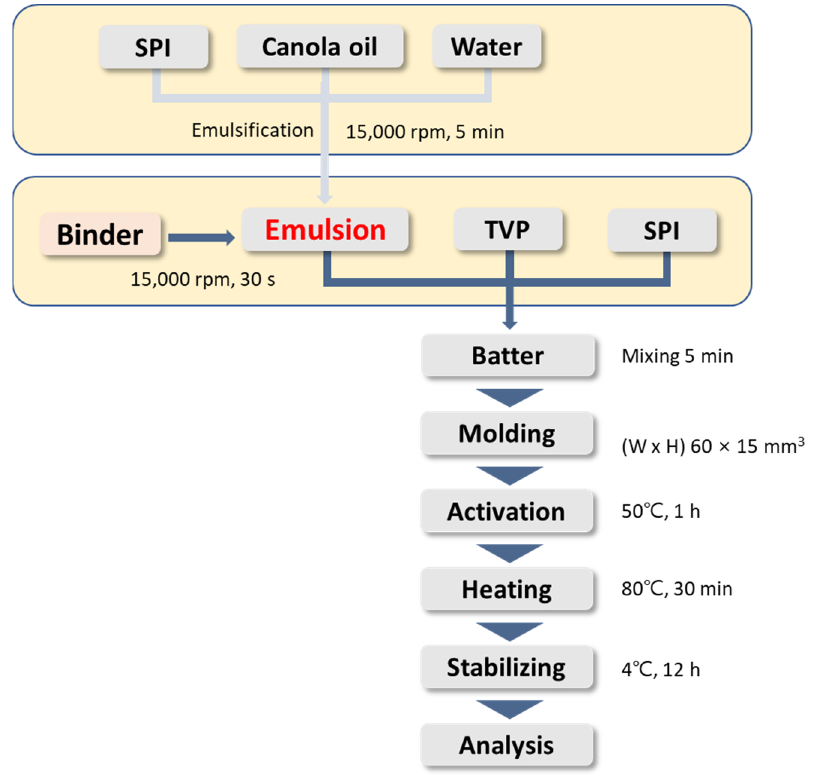
Figure 1. Flow diagram for the manufacture of plant-based meat patties (PBMPs) with different binders.